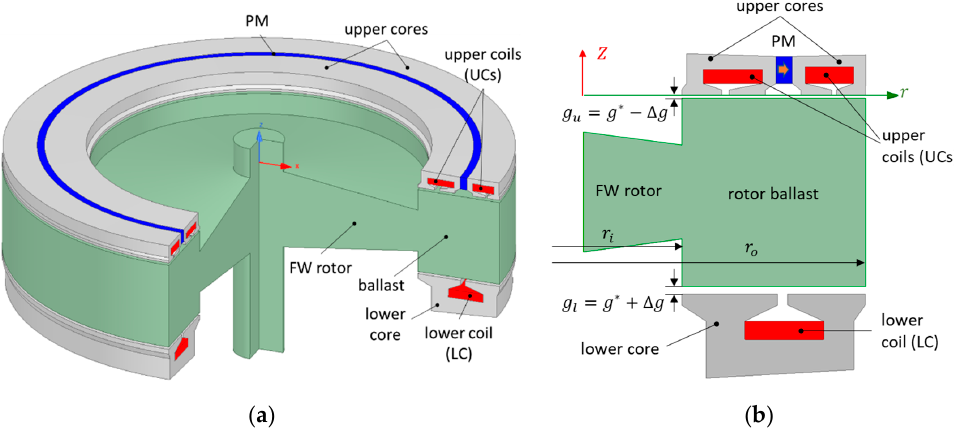
Figure 2. Configuration of the axial hybrid magnetic bearing integrated with the flywheel structure; ( a ) 3D view with split sections; ( b ) 2D section evidencing the axial hybrid magnetic bearing